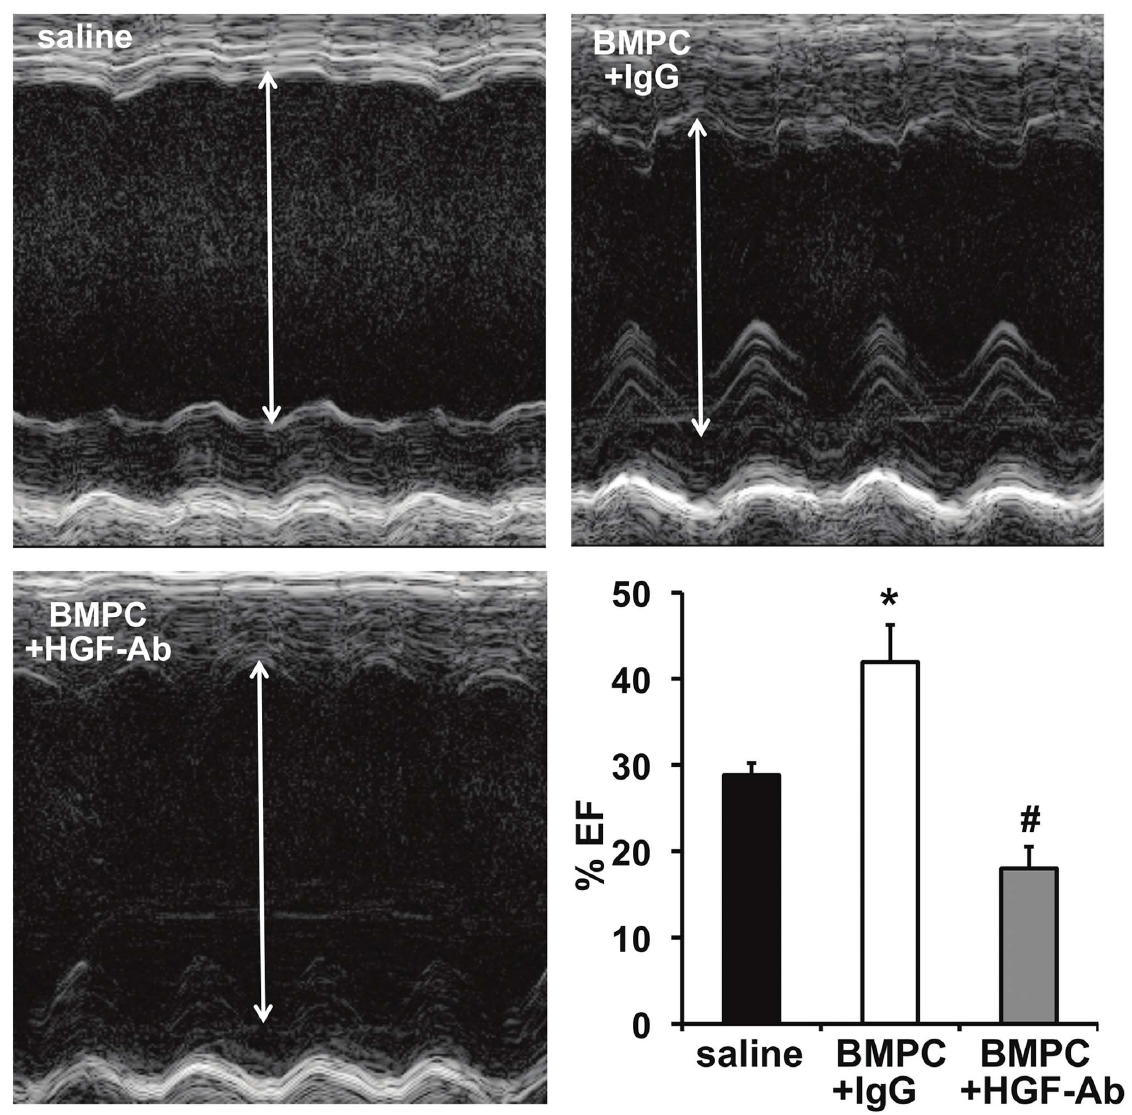
Figure 5. Echocardiographic analysis of LV function in db/db mice receiving BMPC therapy after 28 days post-MI. Ejection fraction (EF) increased following BMPC therapy (improvement in cardiac function) in comparison with saline-treated group. Administration of neutralizing antibodies against HGF (HGF-Ab) worsened LV function as compared to IgG treated group. *P , 0.05 vs saline group; # P , 0.05 versus IgG treated group. HGF-Ab indicates antibodies against hepatocyte growth factor; BMPC, bone marrow-derived progenitor cell. BMPC, bone marrow-derived progenitor cell.